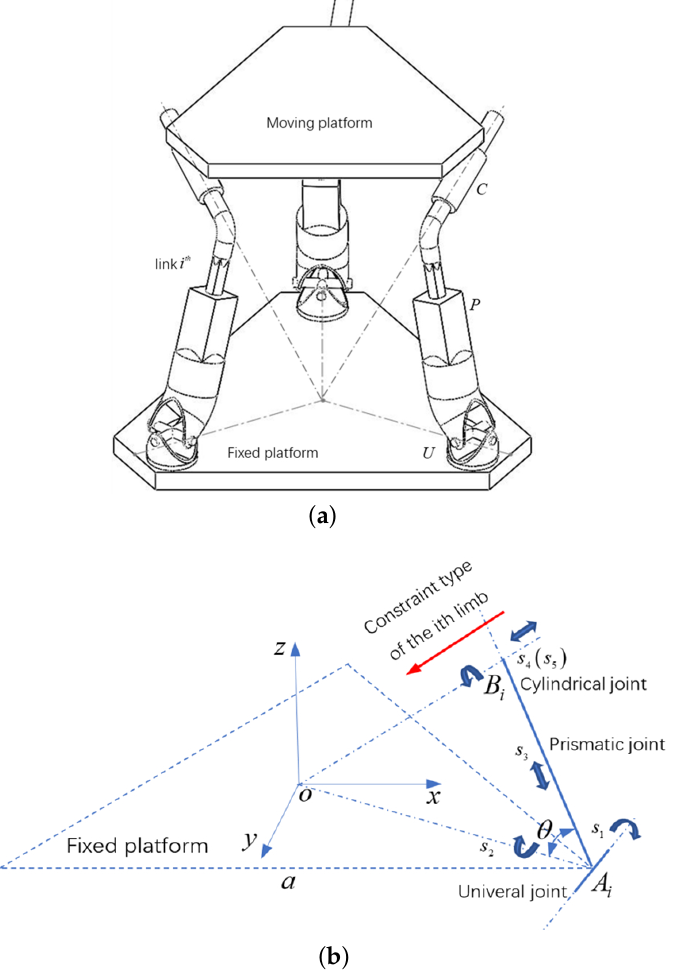
Figure 1. Prototype structure and constraint types of the parallel manipulator with three-translation DOF. ( a ) The overview of prototype structure between the fixed platform and moving platform. ( b ) Constraints of the prototype structure